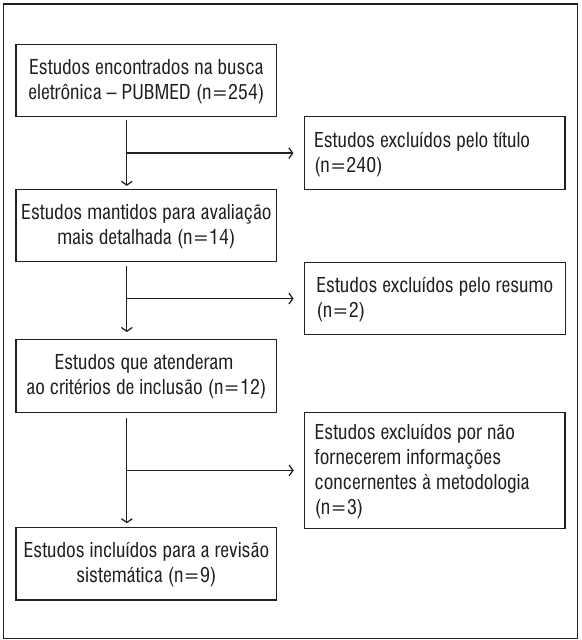
Figura 1 - Fluxograma da busca e seleção dos estudos para Fonte: Dados da